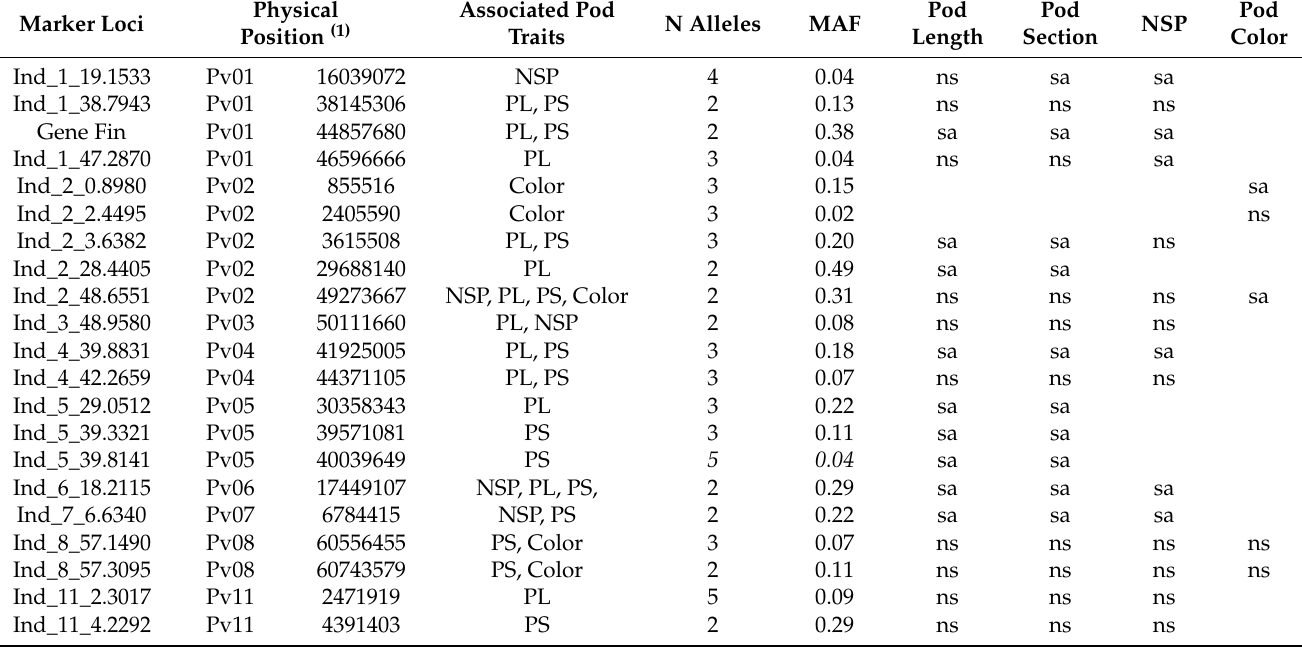
Table 3. Significant associations marker-trait detected in the Core-SBP among marker loci tagging QTL/genes for pod characters recorded in the 2021 field trial. MAF, Minor allele frequency. PL, pod length traits (PL, PLA, PLC, PLPLC). PS, pod cross-section traits (PSA, PSC, PLW, PSH, PSHPSW, PSP). NSP, number of seeds per pod; Color, fresh pod